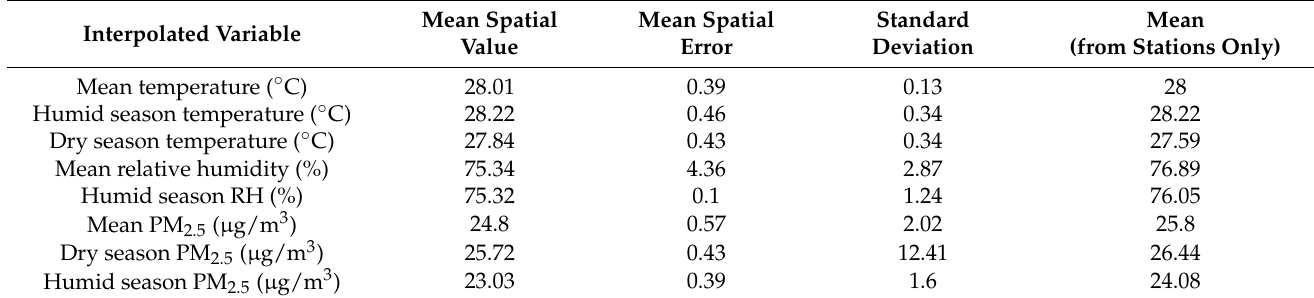
Figure 8. Wind speed interpolation (m/s) in Cartagena (Colombia). Table 6. Results of the interpolations .